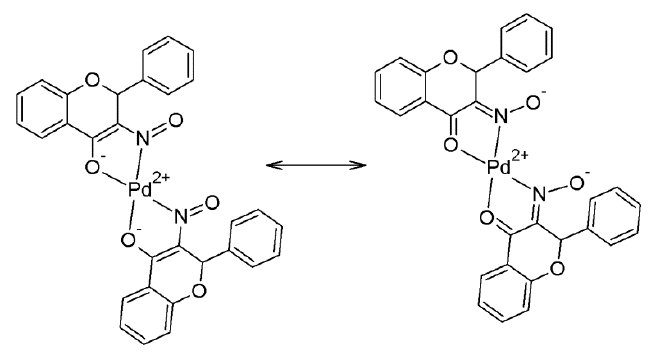
Figure 3. Two resonance forms of Pd(II) complex 2 .